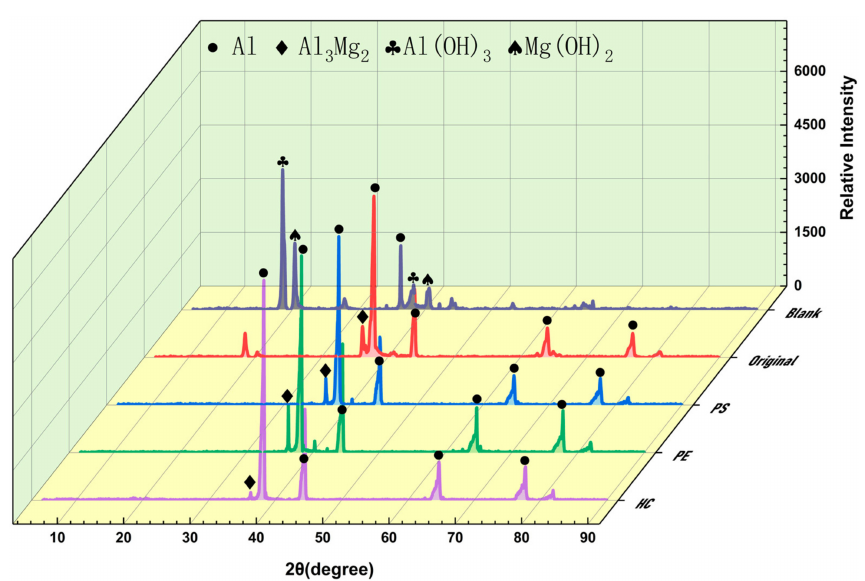
Figure 6. XRD curves of Al alloy before and after dust reaction and after inerting